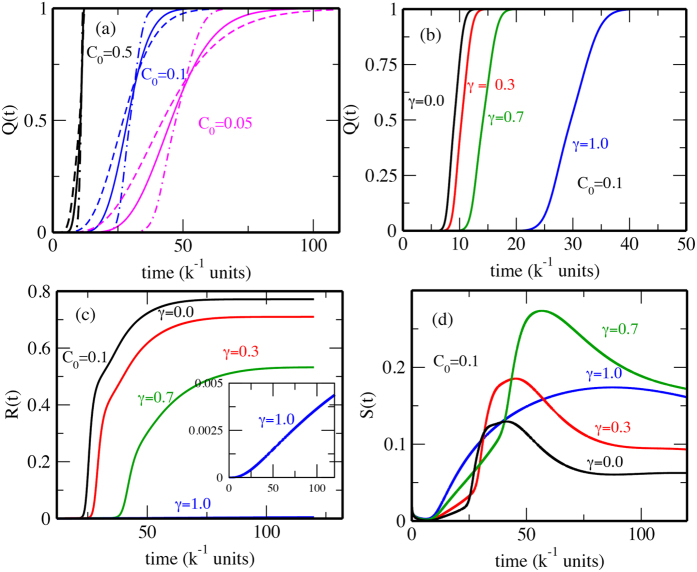
Non-adiabatic ensemble-level kinetics of reprogramming.(a)  and  calculated with the same parameter sets as for  and  of Fig. 4b but with the absorbing boundary condition at the iPSC state with Neff = 5000 (dashed),10000 (bold) and 50000 (dot-dashed). Q5(t) is consistent with experiments. (b) Q(t), (c) R(t), and (d) S(t) with various γ () and C0 = 0.1k. Nthr/Neff = 5 × 10−4 in panel a and Neff = 10000 in b.  and τ = 100k−1 in all panels.